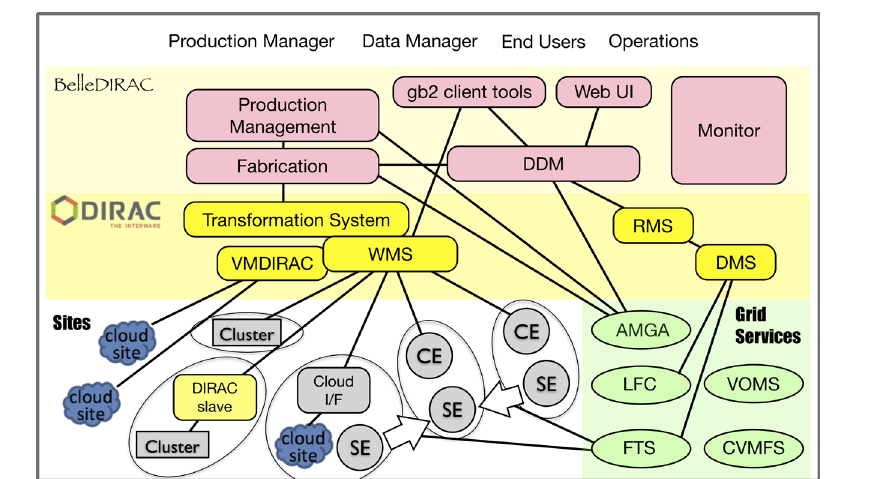
Figure 3: Schematic diagram of the Belle II distributed computing software and middleware